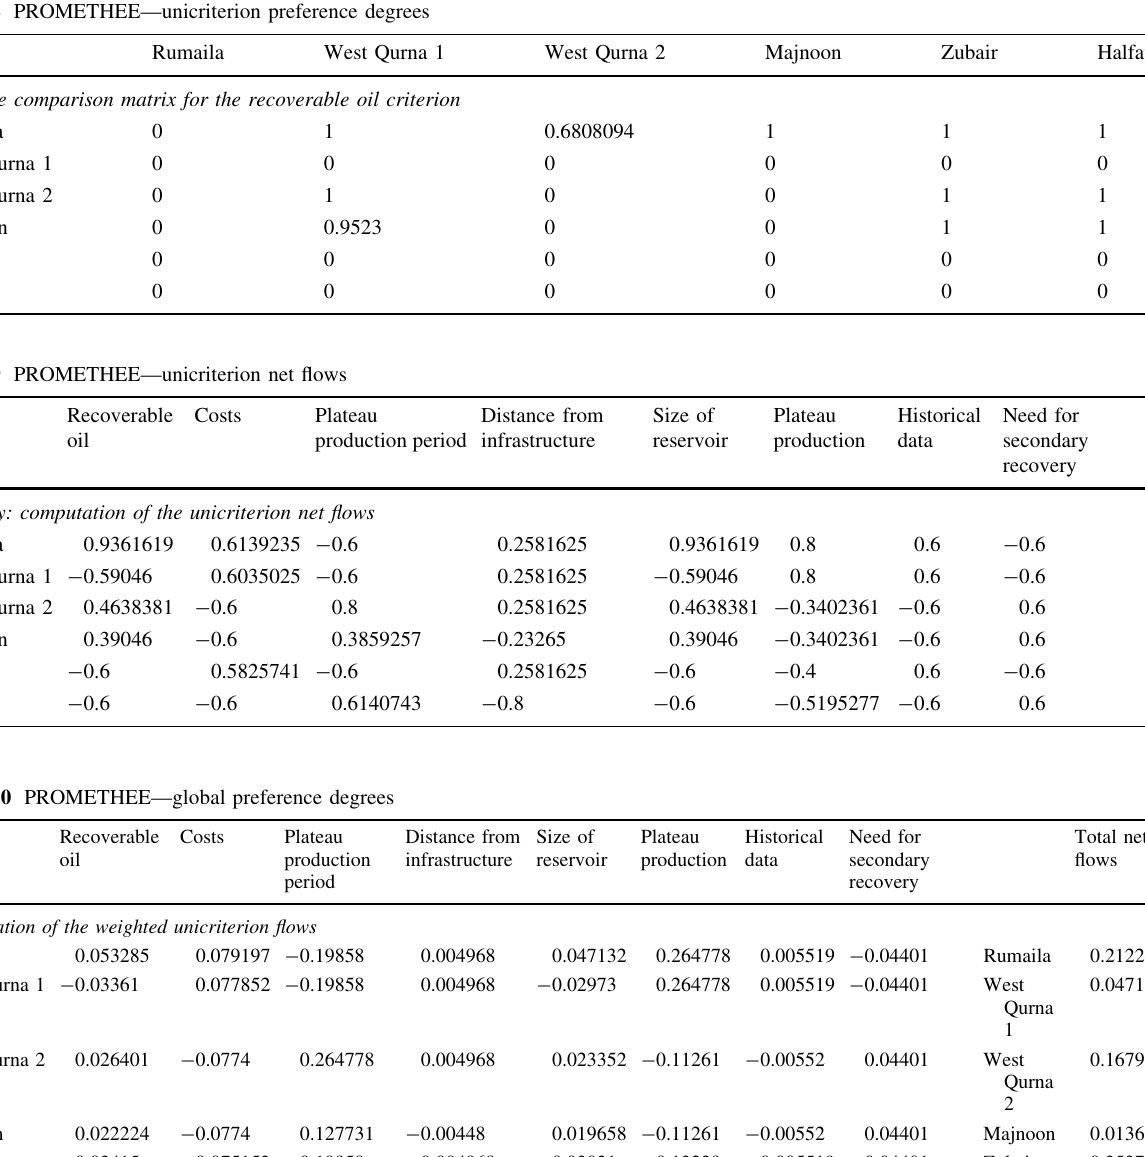
Table 8 PROMETHEE—unicriterion preference degrees